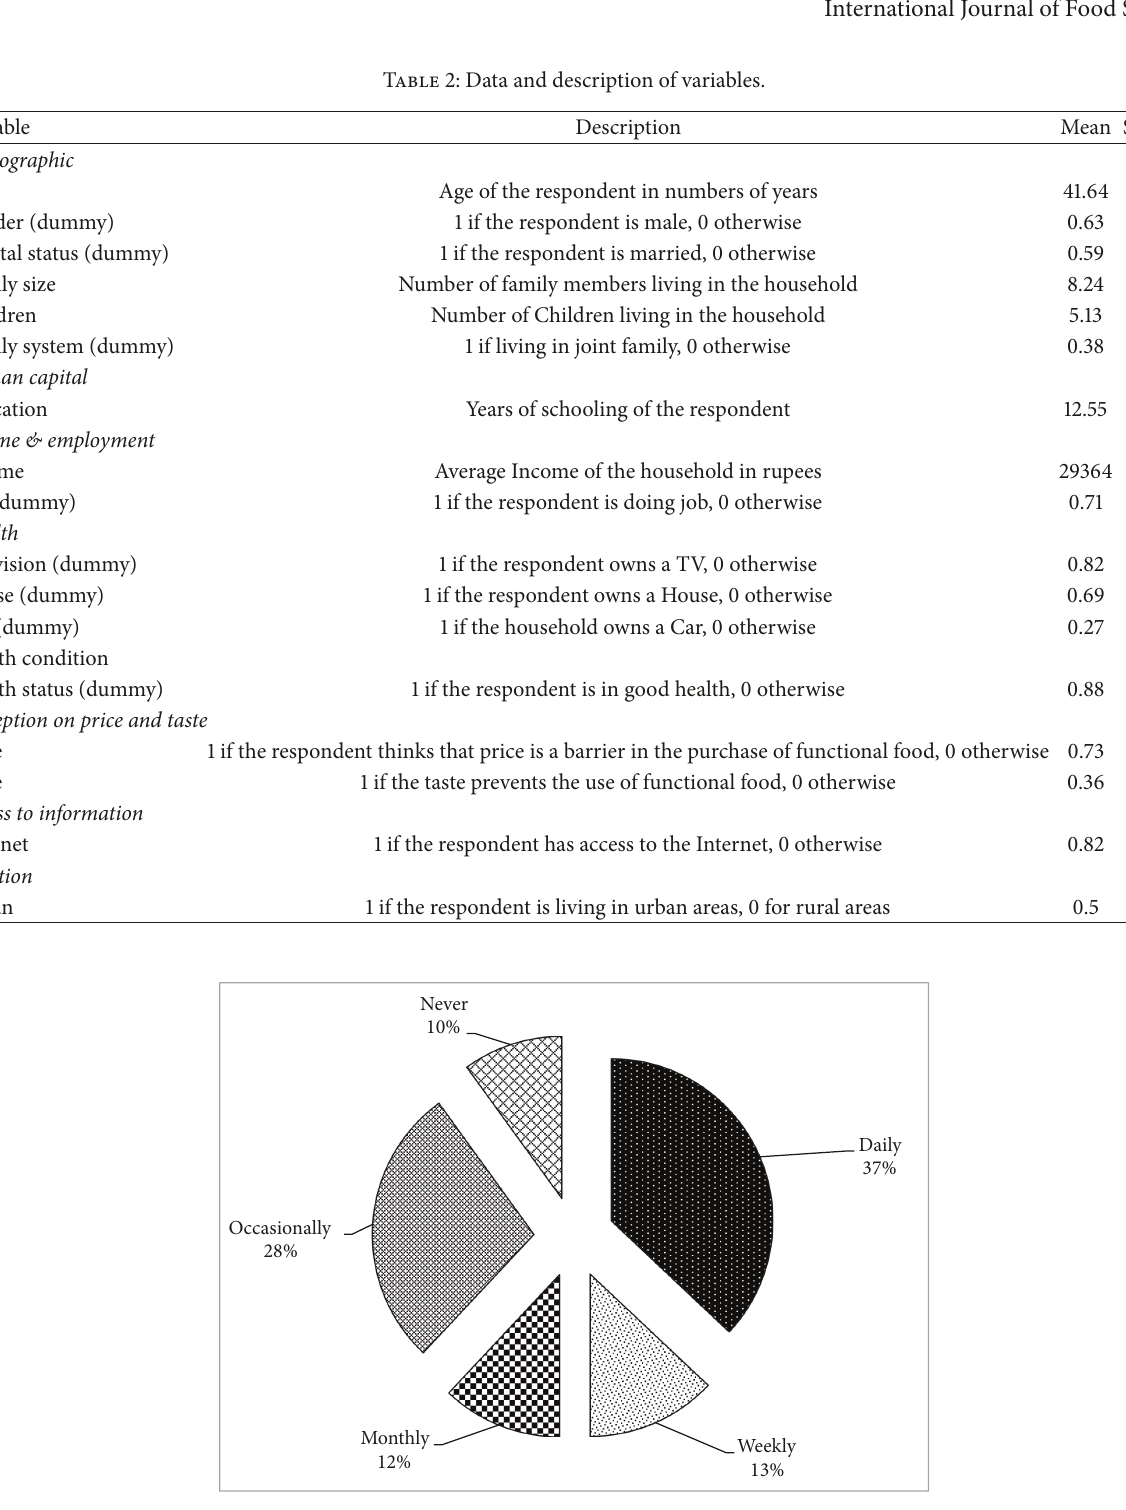
Figure 2: Frequency of functional